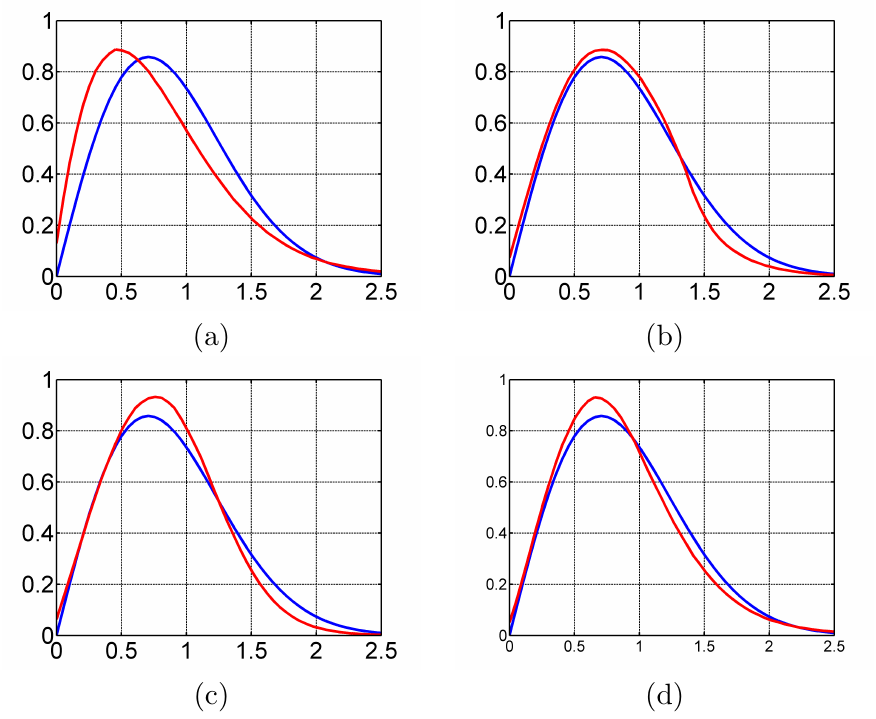
Figure 15. Houston test case. Overlapping of the theoretical speckle PDF (blue line) and the one related to ratio images in amplitude format in the case of: ( a ) Kuan, ( b ) PPB-it, ( c ) FANS, and ( d )